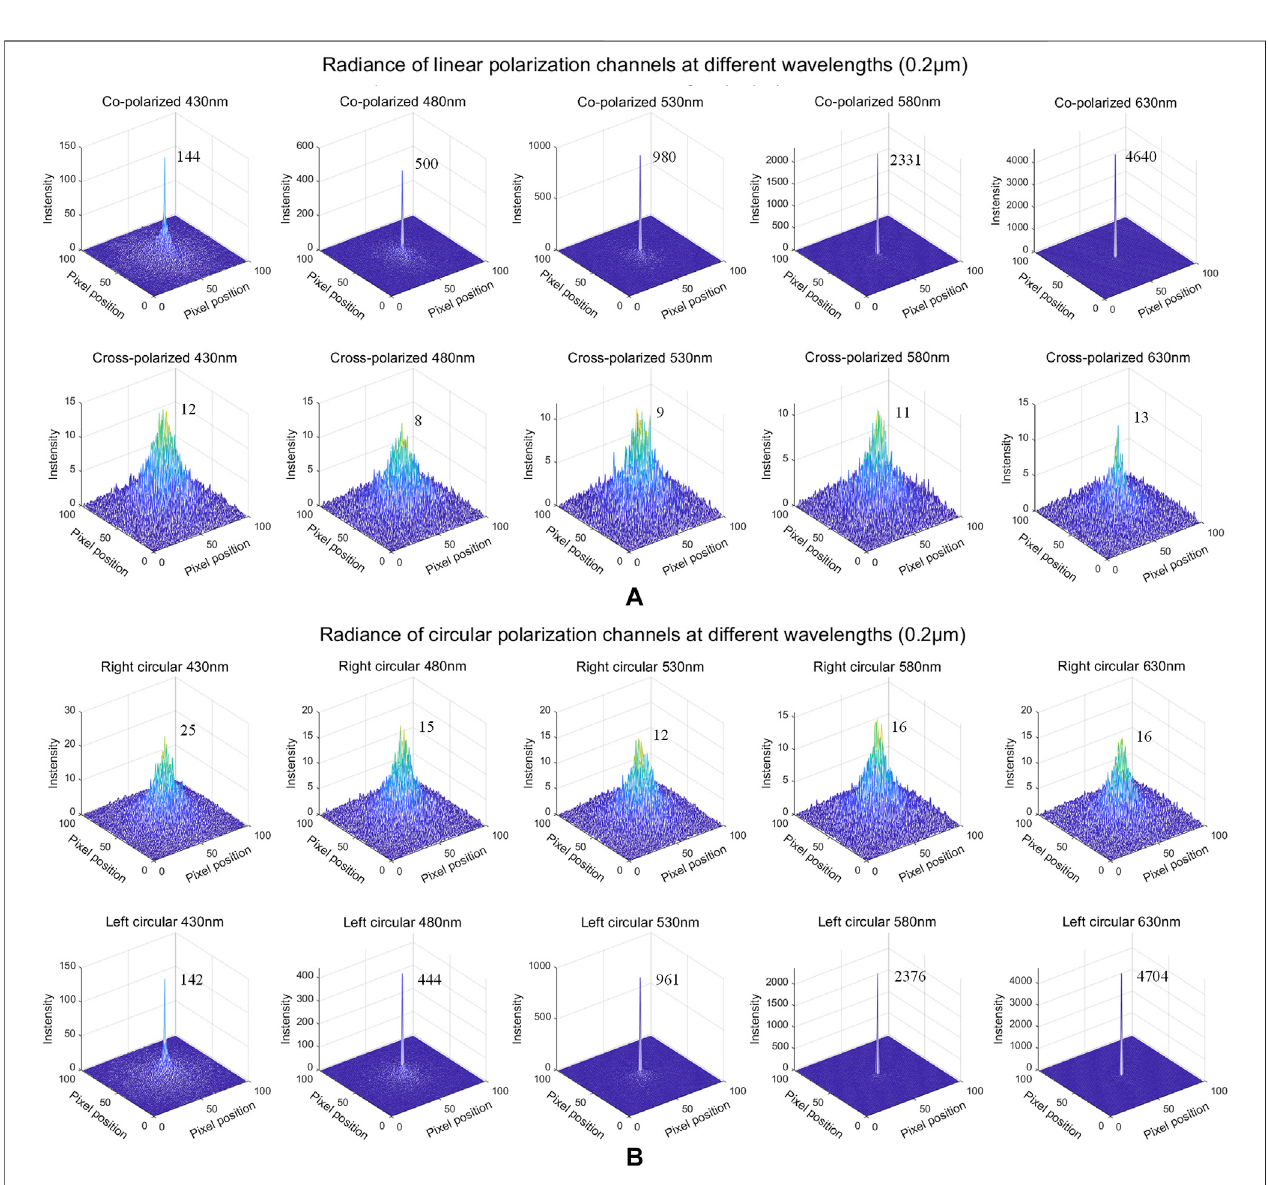
FIGURE 4 | Radiance of polarization channels at different wavelengths in the medium with small-sized particles (0.2 μ m). (A) co-polarized and cross-polarized radiance, (B) right circular and left circular polarized radiance.